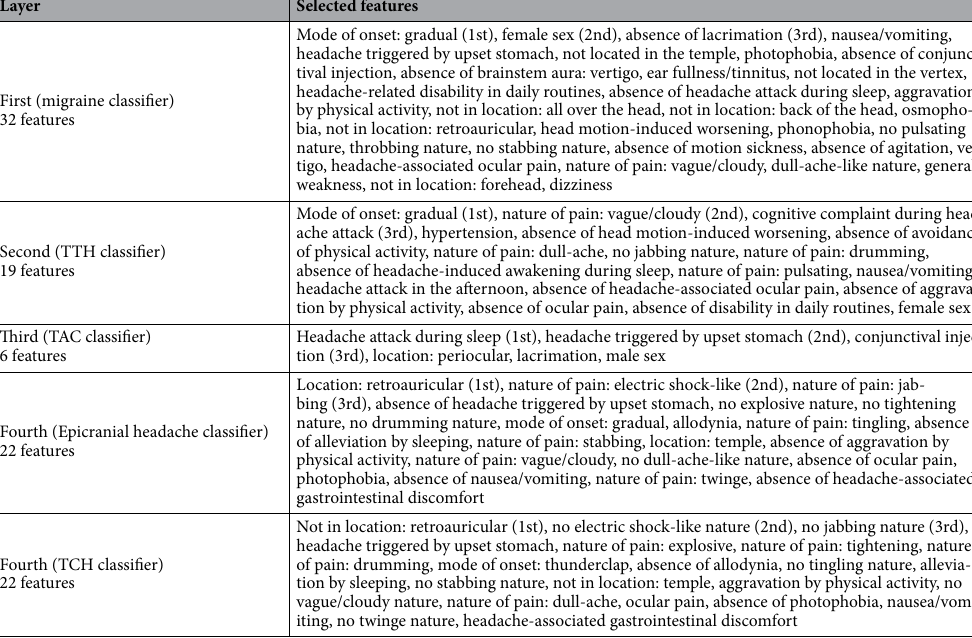
Table 2. Selected features from different layers of the classifier. The features listed in the right column positively correlated with the target subtype listed in the left column. TTH tension-type headache, TAC trigeminal autonomic cephalalgia, TCH thunderclap headache.